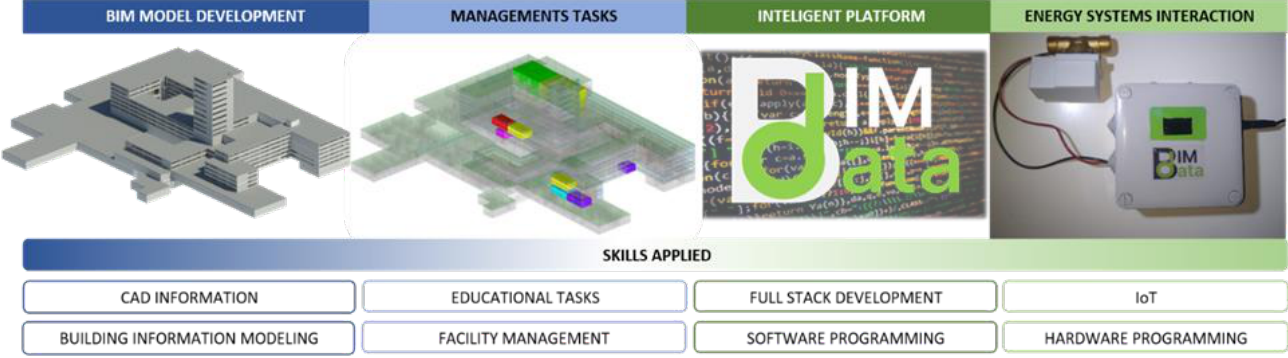
Figure 1. Methodology process followed in the research